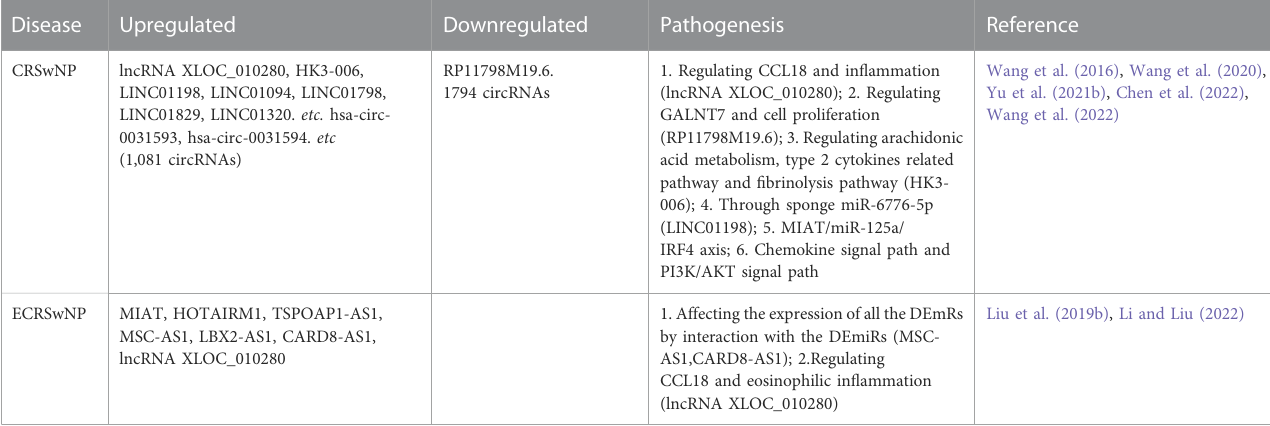
TABLE 3 lncRNAs and circRNAs involved in chronic rhinosinusitis.